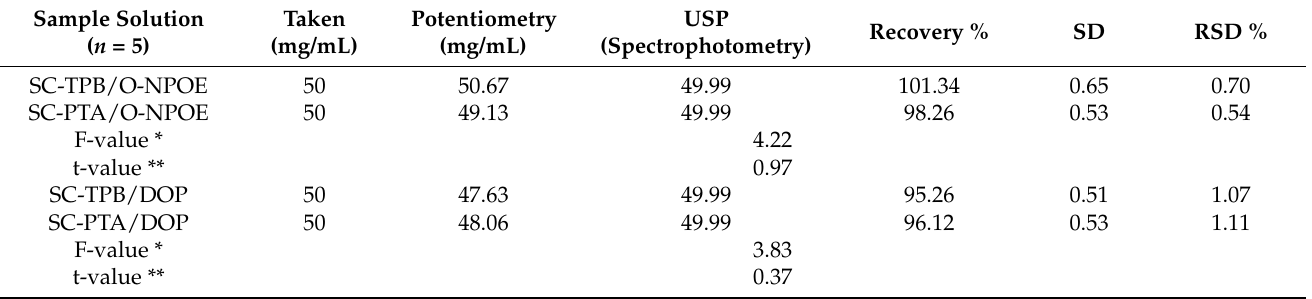
Table 4. Determination of SC in Viagra ® tablets using SC-TPB and SC-PTA with PVC plasticized with O- NPOE or DOP.